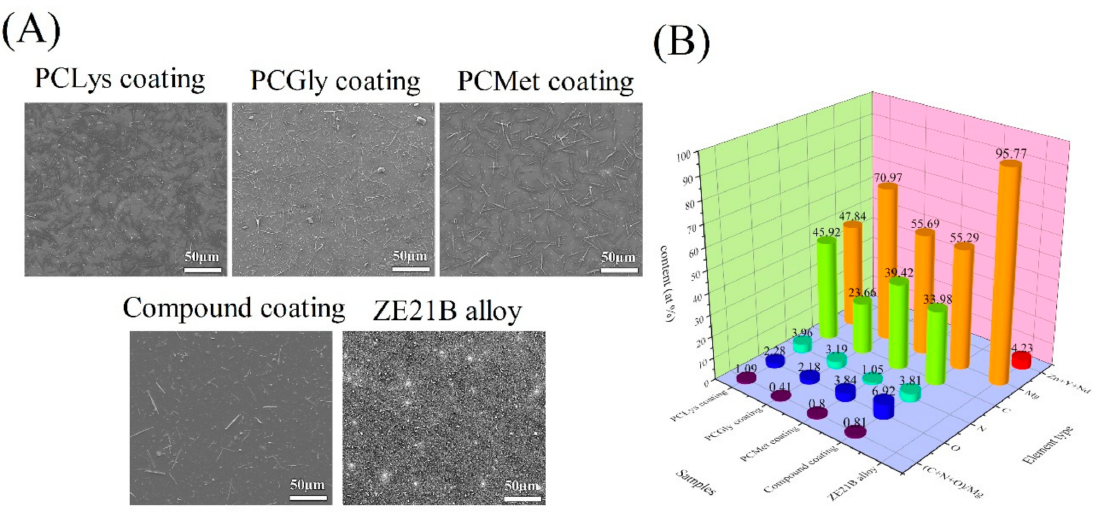
Figure 2. ( A ) SEM images of PCLys-, PCGly-, PCMet-, and compound Schiff base-coated ZE21B samples, and the bare ZE21B; ( B ) EDS element content histogram of each sample surface.